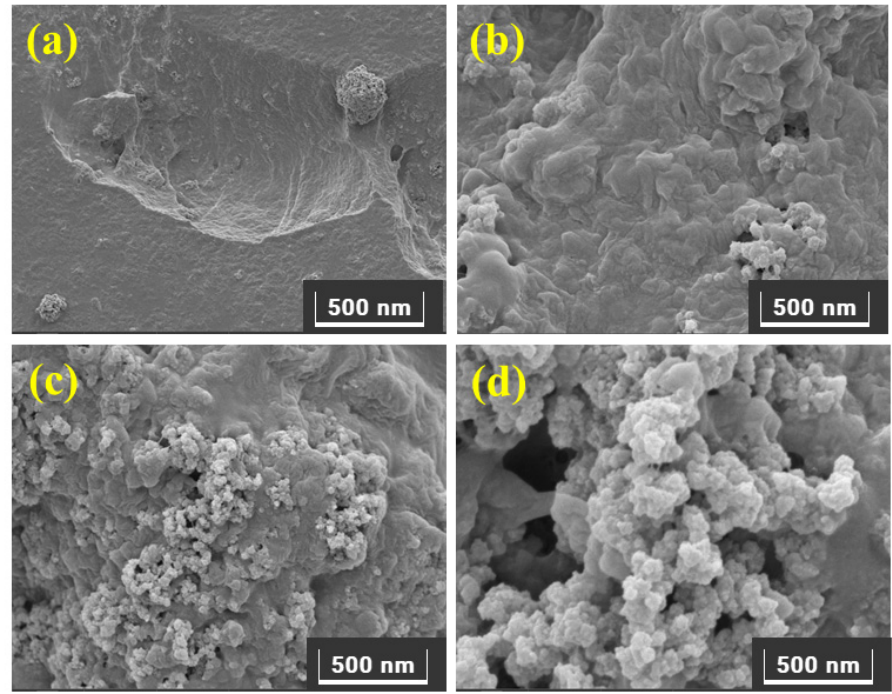
Figure 4. Surface morphology of ( a ) poly[veim][Br]-TRIM, ( b ) poly[veim][Tf 2 N]-TRIM, ( c ) poly[veim][Tf 2 N]-TRIM after MB, and ( d ) poly[veim][Tf 2 N]-TRIM after O-II